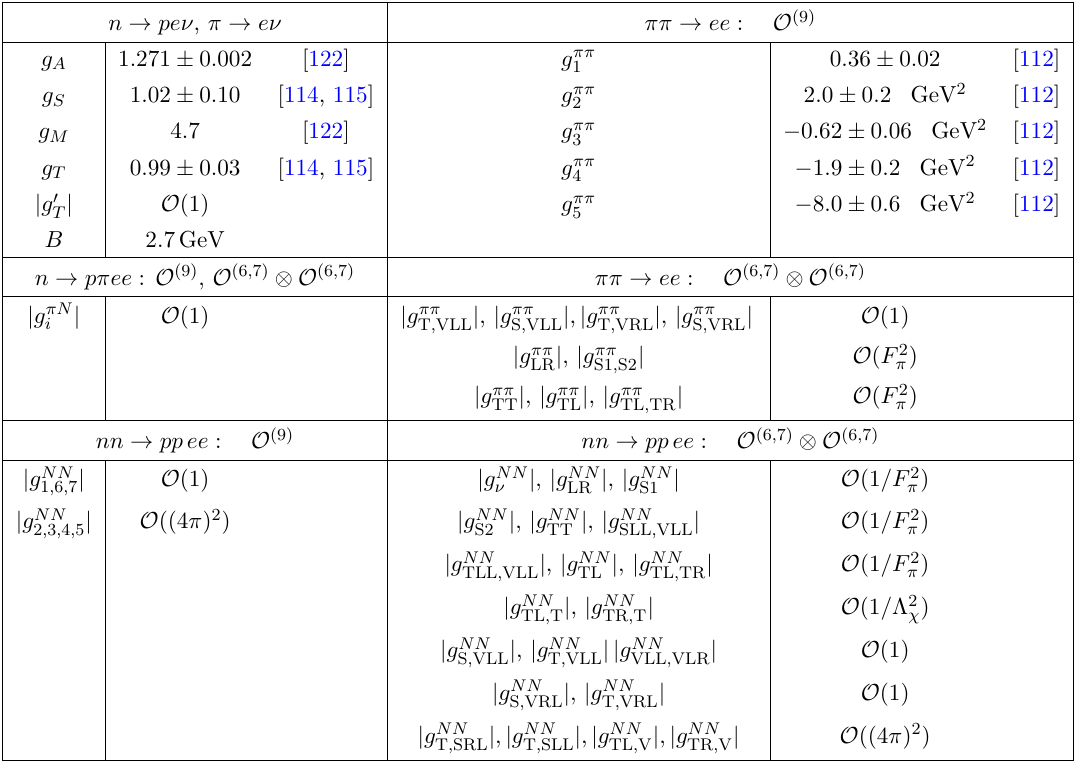
duced by dim-6, -7 and -9 operators, is much more uncertain. At the moment, only the combination g NN (0) + g NN (0) is known, in a variety of renormalization schemes [51, (cid:23) LR